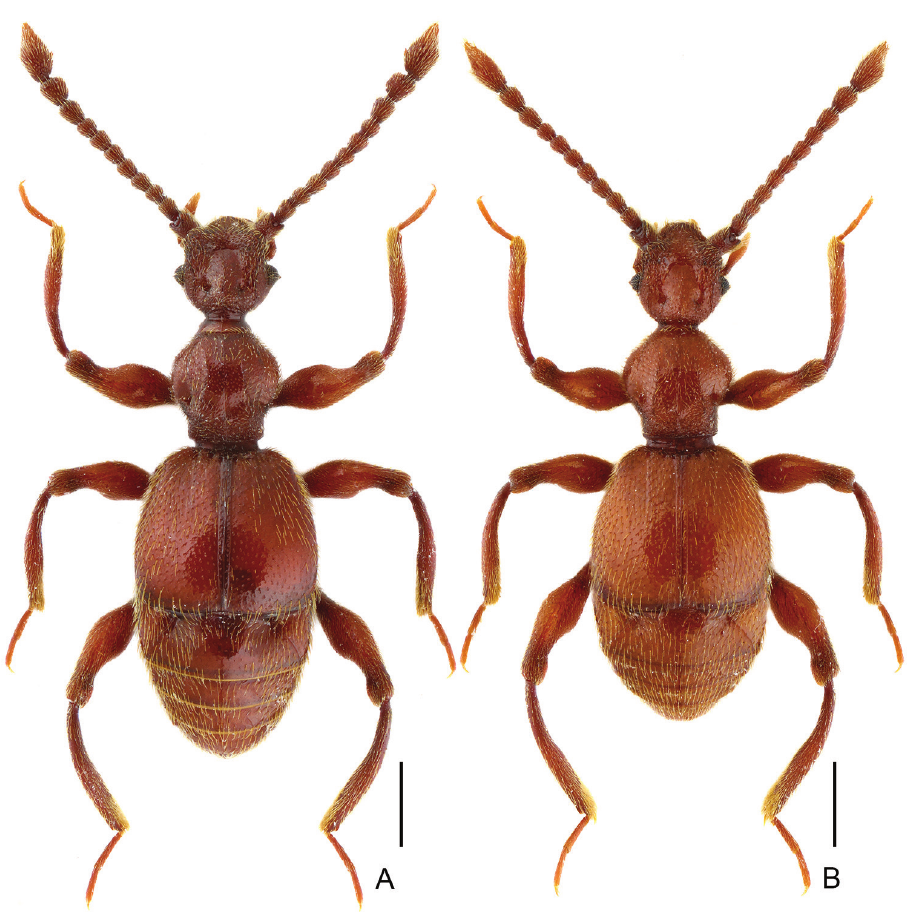
Figure 5. Dorsal habitus of Batrisodes simianshanus . A Male B Female. Scale bars: 0.5